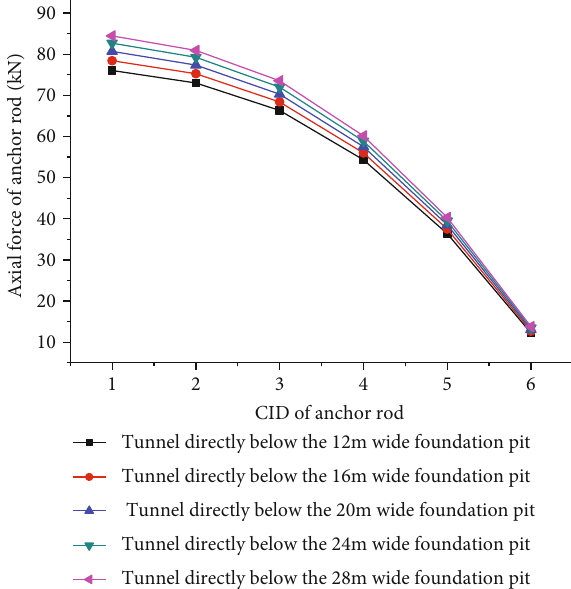
Figure 14: Axial force of the leftmost anchor bolt of a buried tunnel under a 10m deep pit of di ff erent